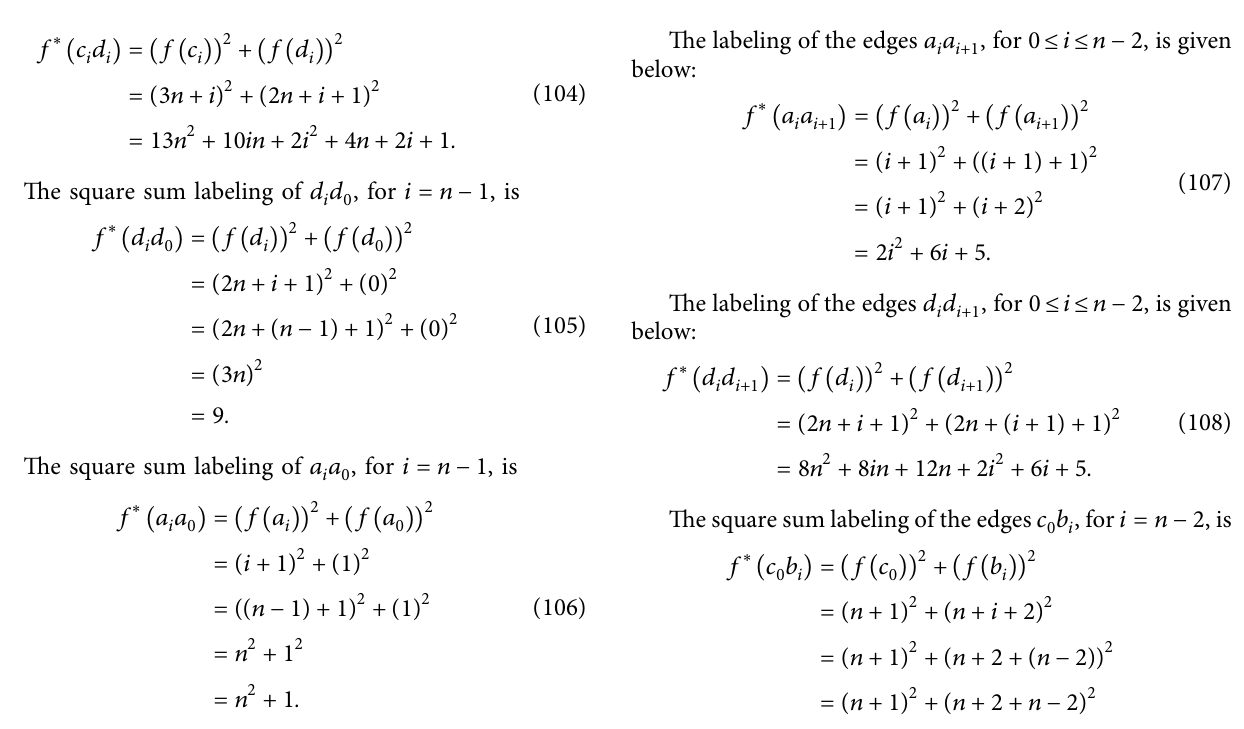
Figure 6: Square sum labeling of double generalized Petersen graph